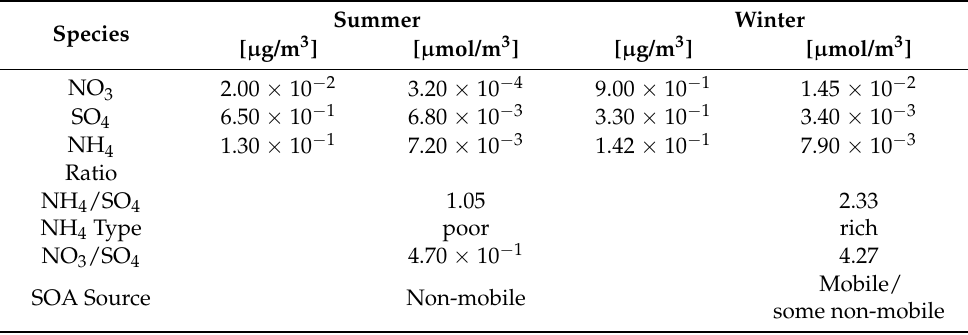
Table 4. Summary of NO 3 , SO 4 , and NH 4 ratios governing SOA